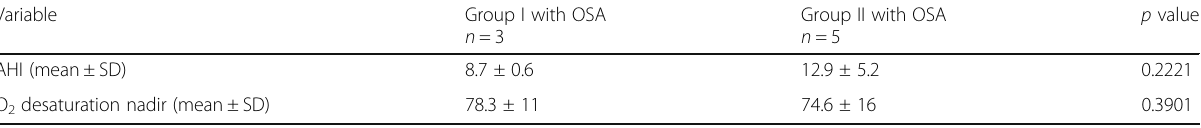
Table 3 Comparison between respiratory events among patients with OSA in both groups Variable Group I with OSA